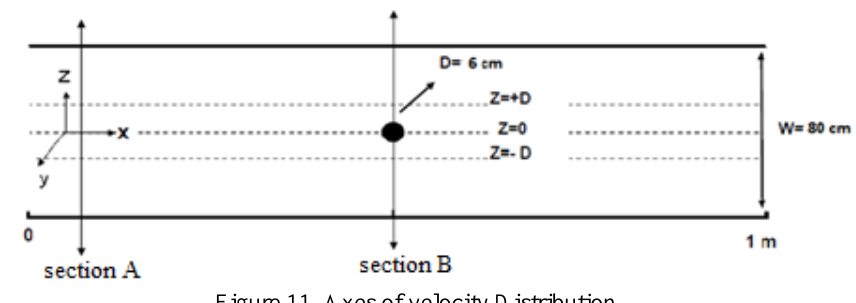
Figure 11. Axes of velocity Distribution